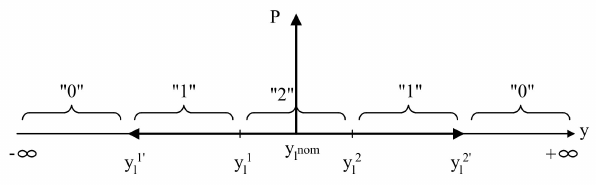
Figure 5. Ranges of the changes of the output function